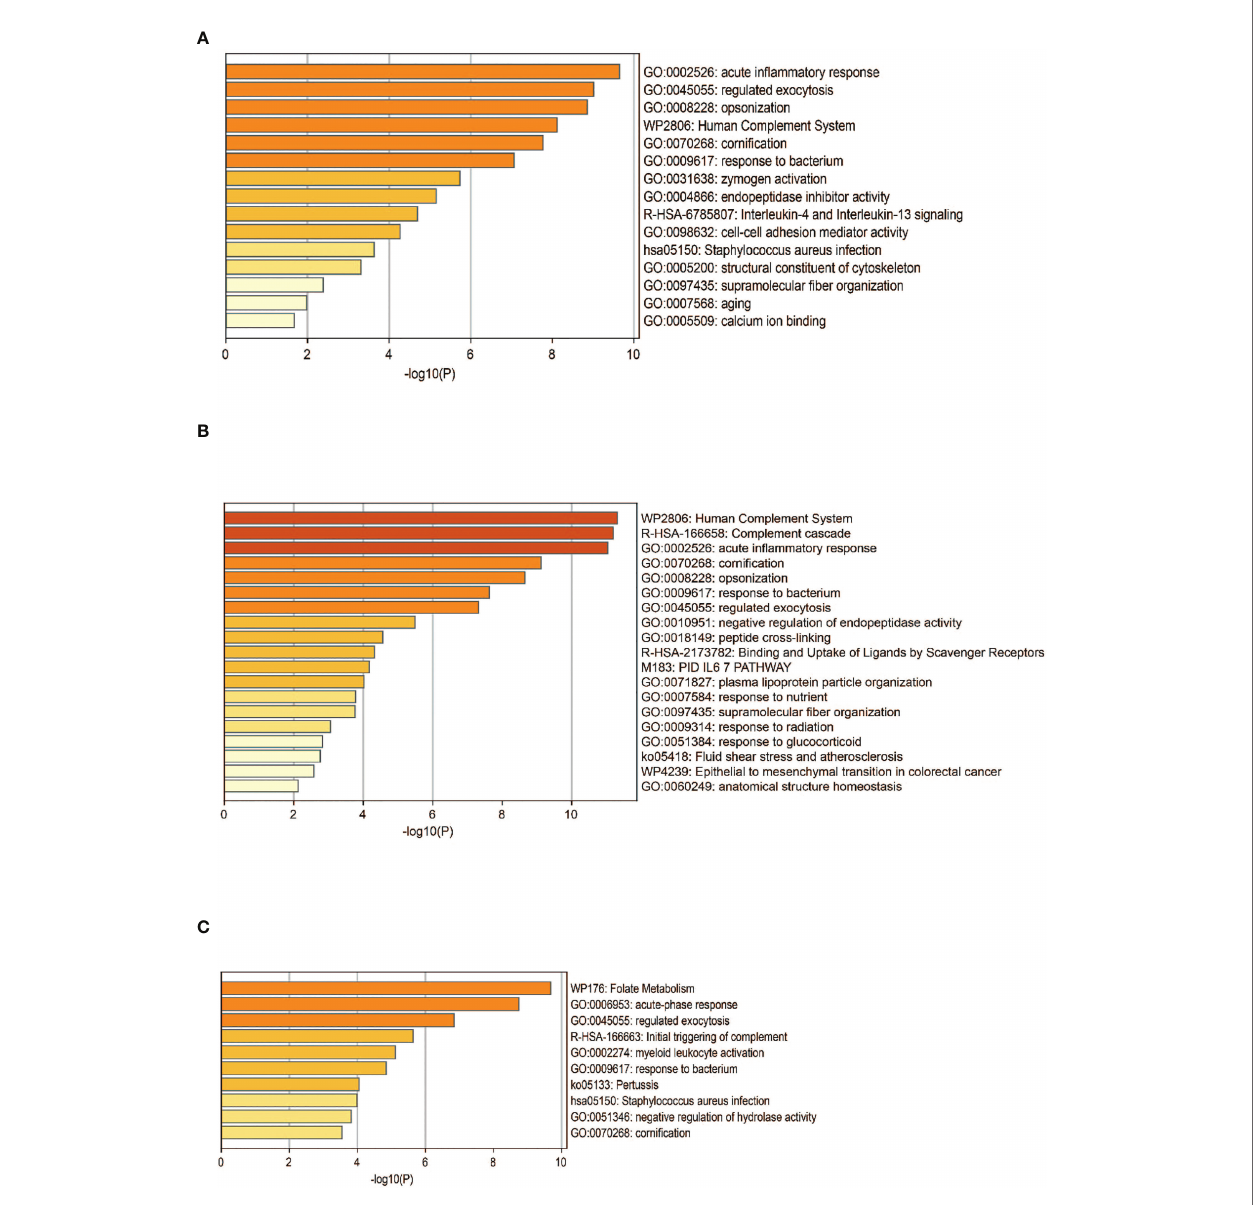
FIGURE 4 | Functional analysis of DEPS. Pathway analysis of DEPs in patients with RA (A) , ACPA-positive RA (B) , and ACPA-negative RA (C) . GO, gene